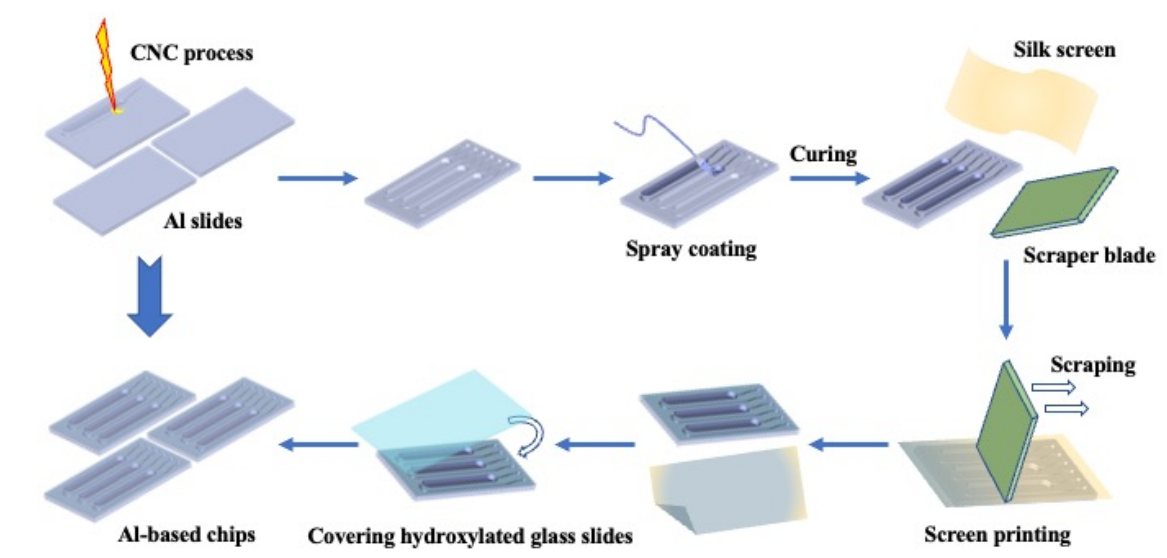
Scheme 1. Schematic representation of process flow for the aluminum-based